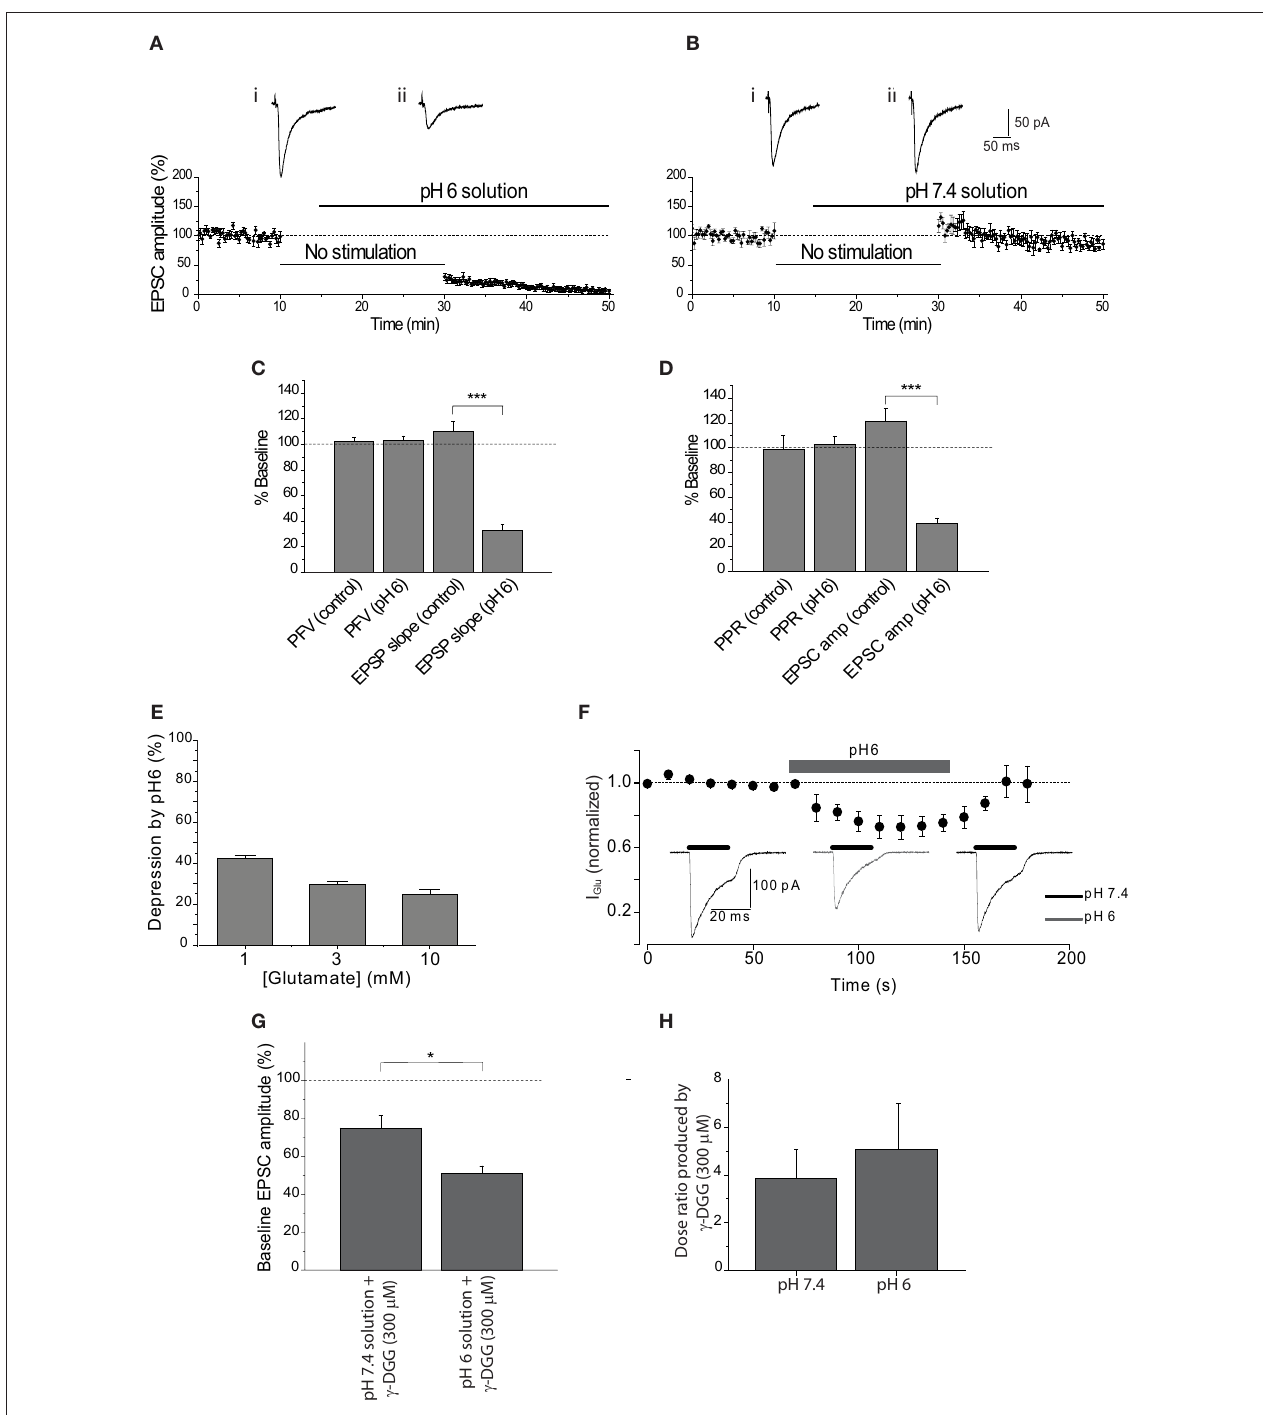
Figure 1 | extracellular acidosis reduces the ePSC. (A) EPSC amplitude was reduced by approximately 70% after stimulation was resumed in the presence of pH6 aCSF. Representative EPSCs show the final baseline response (i) and the first response in pH6 solution (ii). (B) Application of pH7.4 augmented EPSC amplitude following the absence of stimulation, apparent in traces of the final baseline response (i) and the first response evoked in pH7.4 (ii). (C) Initial PFV amplitudes in pH6 and pH7.4 solutions are not significantly different, in contrast to reduction of the initial EPSP slope by pH6. (D) Initial PPR ratios in pH6 and pH7.4 are